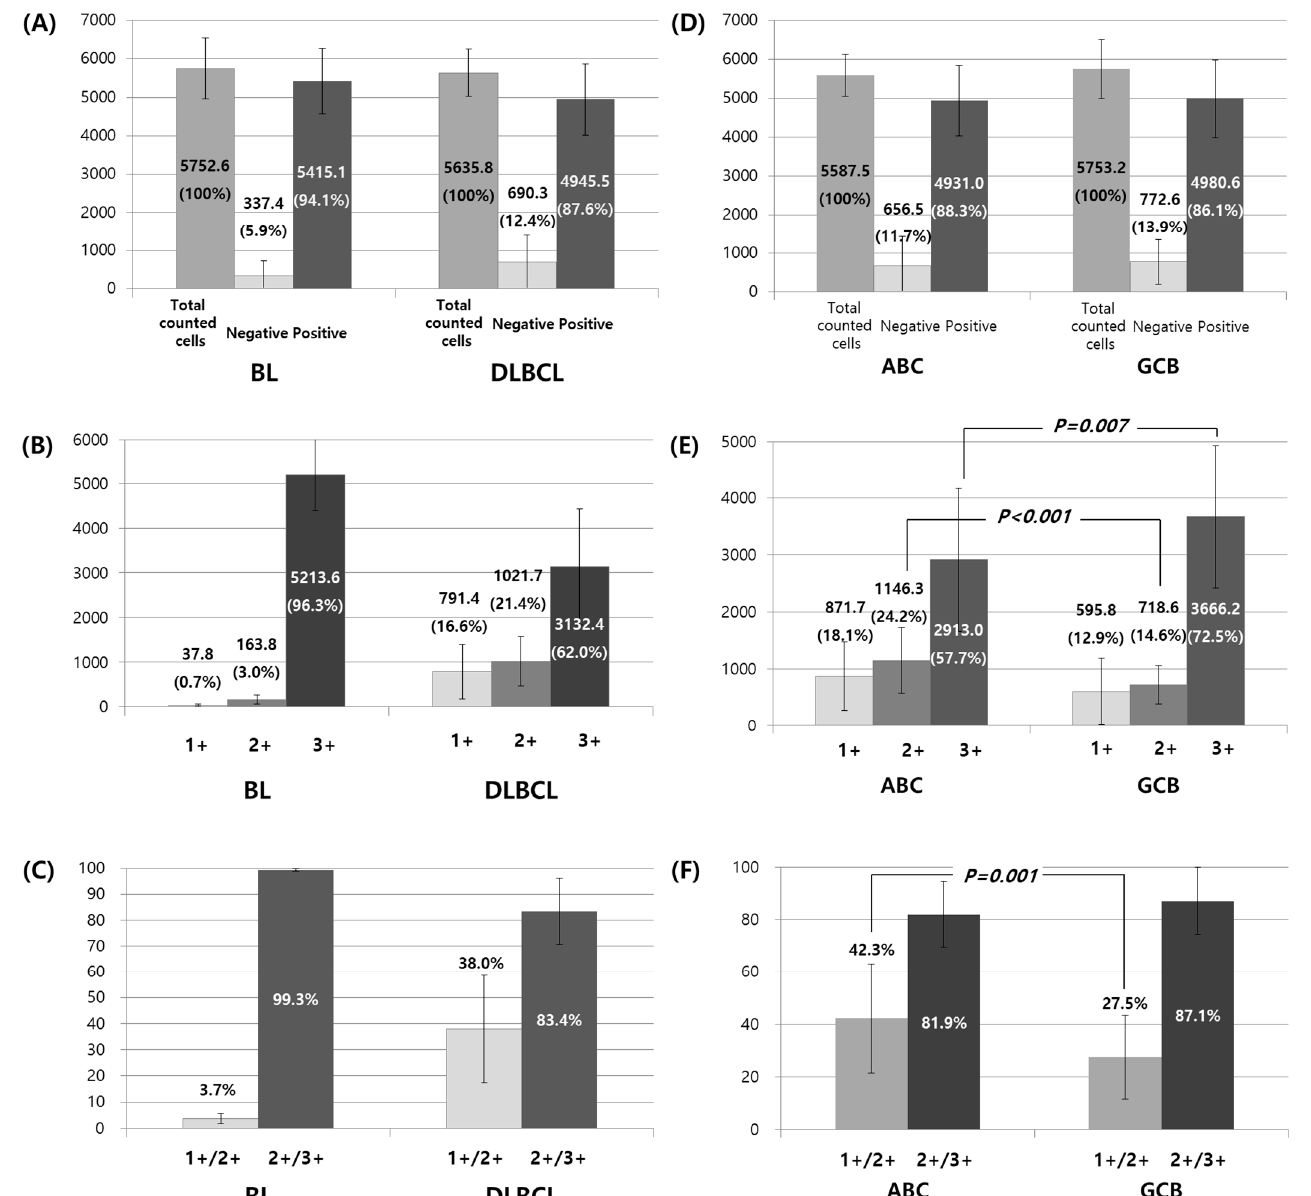
Figure 2. Comparison of Ki-67 labeling index patterns between Burkitt lymphomas (BLs) and diffuse large B-cell lymphomas (DLBCLs) ( A – C ) and between activated B-cell (ABC) and germinal center cell (GCB) subtypes of DLBCLs ( D – F ). Chi-square, Fisher’s exact, Student’s t -test, or Mann – Whitney test were used for two-group comparisons. The one-way analysis of variance or Kruskal – Wallis test were used for three-group comparisons.